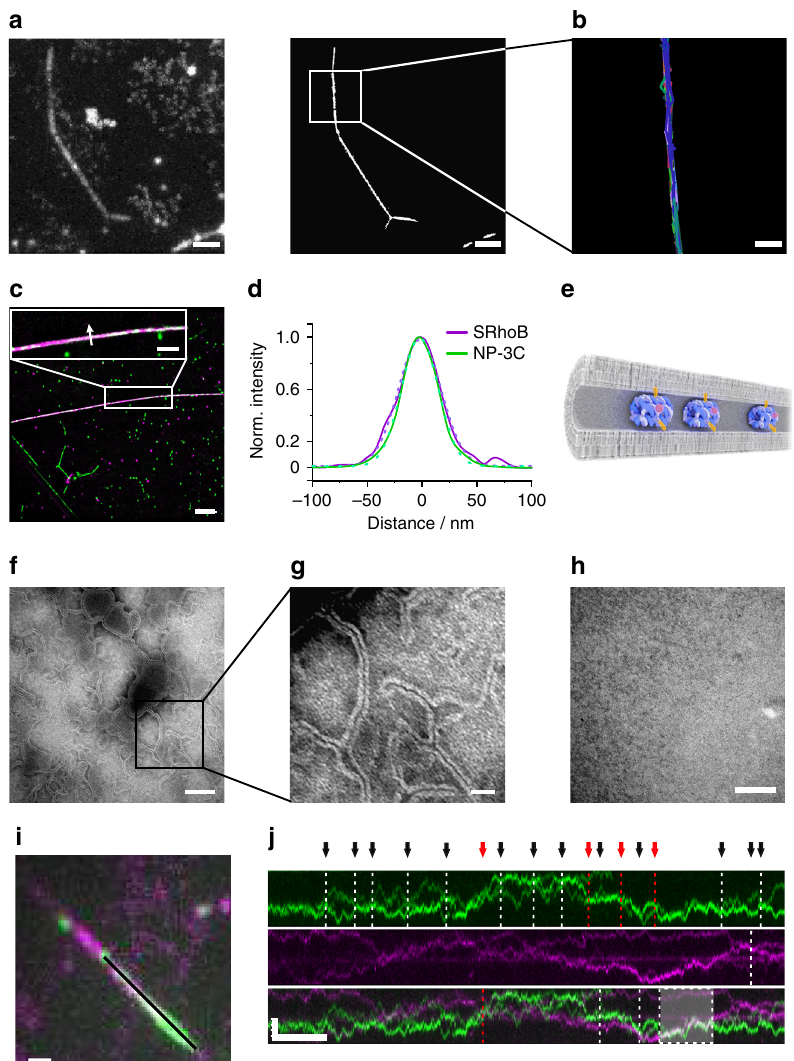
Fig. 6 Formation of lipid nanotubes observed in presence of NP-3C. a , b Typical lipid nanotube on the surface of a PSM observed in presence of AF647 NP- 3C resolved by tracking and localization microscopy (TALM). a Maximum intensity projection (left) and superresolution TALM image (right) of AF647 NP- 3C diffusion in a lipid nanotube. Scale bars: 2 µ m. b Trajectories of AF647 NP-3C. Scale bar: 500 nm. c Dual-color superresolution TALM images of sulforhodamine B (SRhoB, magenta) and AF647 NP-3C (green) obtained by rendering single-molecule localizations from 325 consecutive frames. Scale bar: 5 µ m. d Pro fi les of localized AF647 and SRhoB signals across the tube depicted by the arrow with a Gaussian fi t (dotted line). The full-width at half maximum (FWHM) for AF647 NP-3C and SRhoB was 38 ± 3 nm and 45 ± 2 nm, respectively ( n = 6 for each channel, mean and s.d). e Proposed architecture of NP-3C inside lipid nanotubes. f , g Representative negative stain transmission electron microscopy (TEM) revealing a network of ultrathin lipid tubes. Scale bar: 100 nm ( f ) and 25 nm ( g ). h Negative control TEM image of a membrane on a carbon fi lm in absence of DNA NPs. Scale bar: 100 nm. i Maximum intensity projection of 150 consecutive frames of AF647 NP-3C (green) and Cy3 NP-3C (magenta) including a merged image. Scale bar: 1 µ m. j Kymographs of AF647 NP-3C (green) and Cy3 NP3C (magenta) diffusion along the black line indicated in i , shown in separate and merged channels. Black arrows indicate collisions between individual NPs, red arrows highlight crossing events, while the shaded area shows elongated co-diffusion along the nanotubes. Scale bars: 2 µ m (vertical), 500 ms